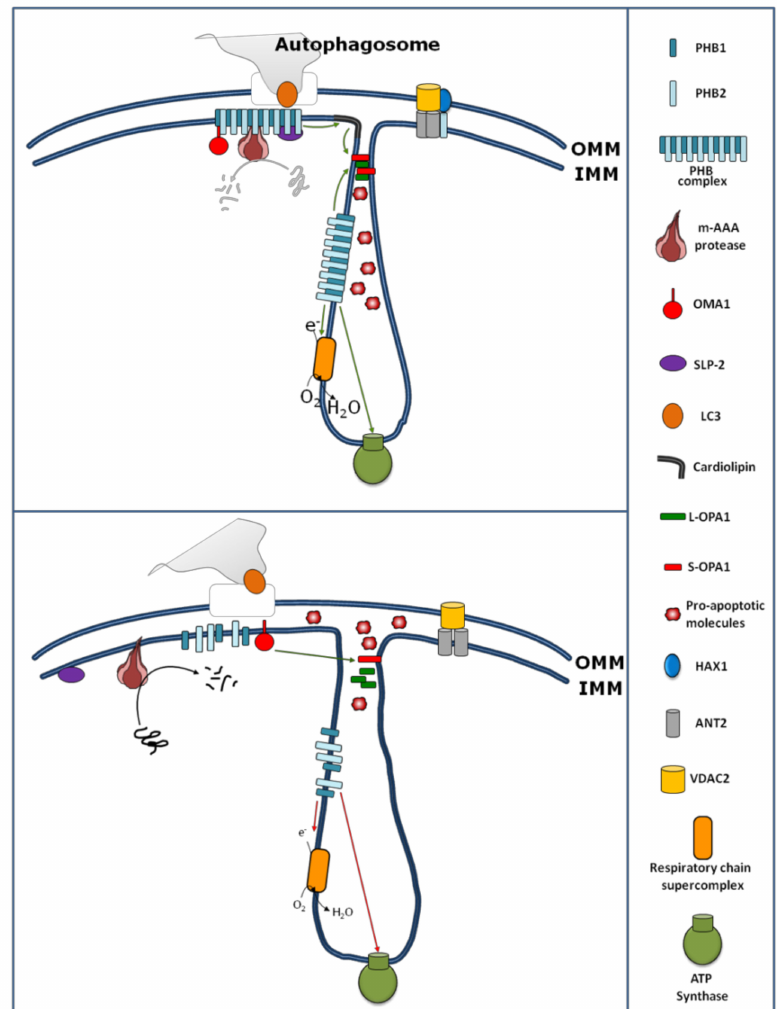
Figure 1. Role of the PHB complex and PHB proteins in mitochondrial functions. ( Upper panel ) The PHB complex interacts with m -AAA [11] and OMA1 proteases [30], inhibiting their activity, and with SLP-2 protein [31], resulting in a reciprocal protein stabilization. The stabilization of the PHB complex affects the maturation of cardiolipin [32] that, in turn, together with the PHB complex, promotes the stabilization of OPA1 [24,33] and the formation of the respiratory chain supercomplex mboxciteB34-cells-413140,B35-cells-413140. The PHB complex also ensures a correct biogenesis of the ATP synthase [36]. PHB2 protein also has a role as a receptor for selective autophagy (mitophagy) by interacting with LC3 through its LC3-interacting domain [37]. Independently to its binding to PHB1, PHB2 forms another complex with HAX1, VDAC, and ANT3 [23]. ( Lower panel ) The down-regulation of PHBs and the loss of the PHB complex results in the activation of m -AAA [11] and OMA1 [30] proteases, degradation of SLP-2 [31], and a defect in cardiolipin maturation [32]. The increased m -AAA protease activity alters the turnover of unassembled mitochondrial respiratory chain subunits [11]. The increased activity of OMA1 [30] and the altered maturation of cardiolipin [32] result in an increased processing or decreased stability of L-OPA1 [33]. The altered balance between L-OPA1 and S-OPA1 causes mitochondrial fragmentation and alteration of mitochondrial cristae ultrastructure, with a consequent release of pro-apoptotic molecules from the intermembrane space, leading to apoptosis [38]. As with OPA1, the down-regulation of PHB2 leads to proteolysis of HAX1, which is implicated in the mitochondrial permeability transition during apoptosis [23]. OMM: Outer mitochondrial membrane; IMM: Inner mitochondrial